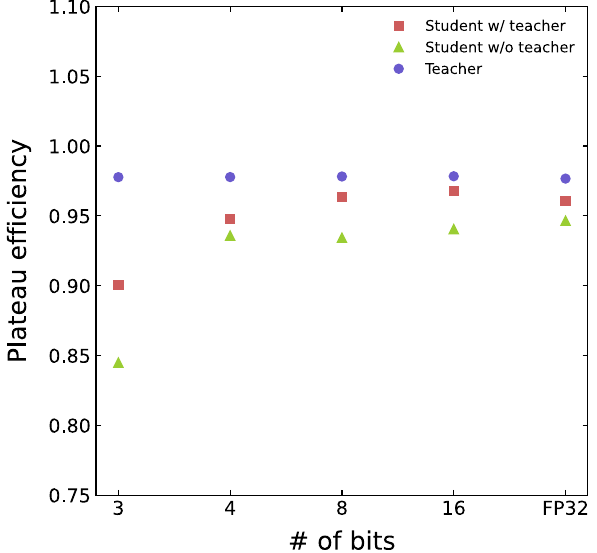
Fig. 11 Efficiency curves (realized as for Fig. 6). Statistical uncertain- ties computed as binomial confidence intervals are shown as well. If not visible, they’re smaller than the markers size. Red triangles (cyan diamonds) represent the performance of the 4-bit Student trained with the hints from the (quantized-)Teacher. Orange circles (blue squares) represent the performance of the 3-bit Student trained with the hints from the (quantized-)Teacher